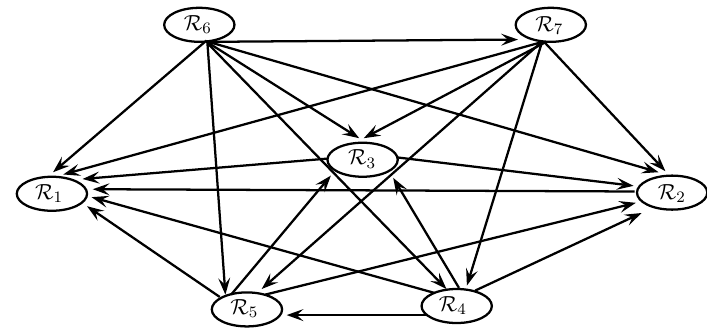
Figure 5. Partial relations of PROMETHEE I. Figure 5: Partial relations of PROMETHEE I